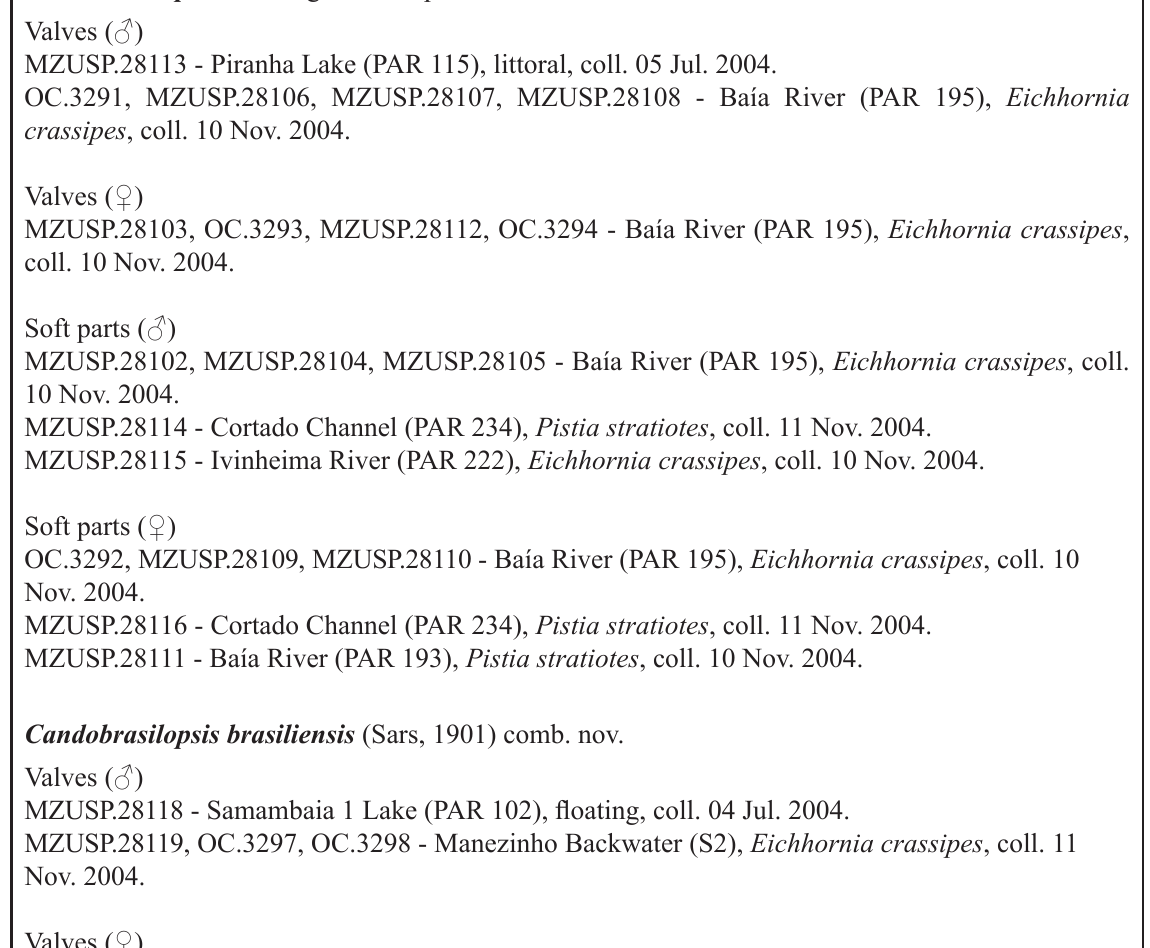
Table 2. Locality data of Candobrasilopsis rochai gen. nov. sp. nov. and Candobrasilopsis brasiliensis (Sars, 1901) comb. nov., material used here. Candobrasilopsis rochai gen. nov. sp.